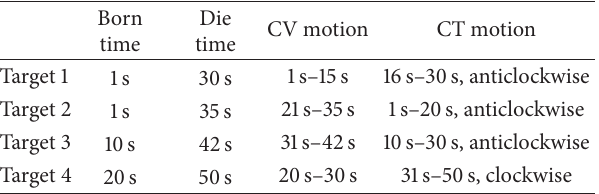
Figure 1: The true trajectories for the maneuvering targets and sensor location. Table 1: The motions of the